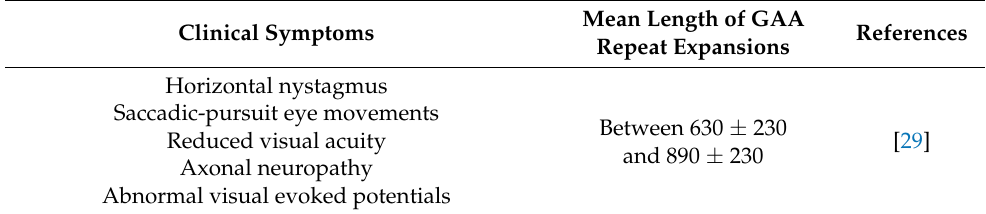
Table 1. Neuro-ophthalmological clinical symptoms associated with a mean length of GAA repeat